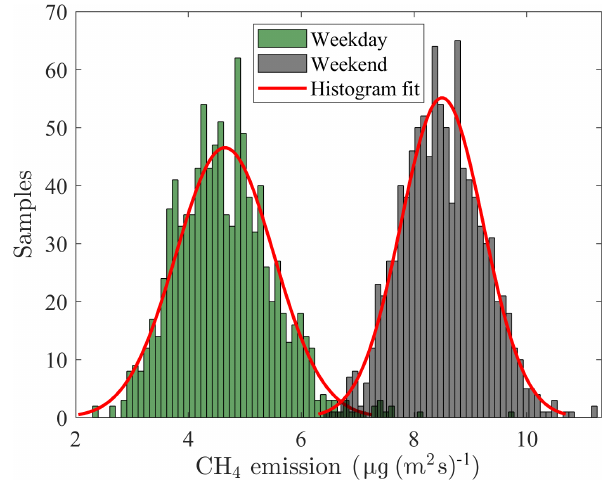
Figure 8. Total CH 4 emission estimates during (light red) and after (blue) the Oktoberfest 2018 including a fitted normal distribution (red line).